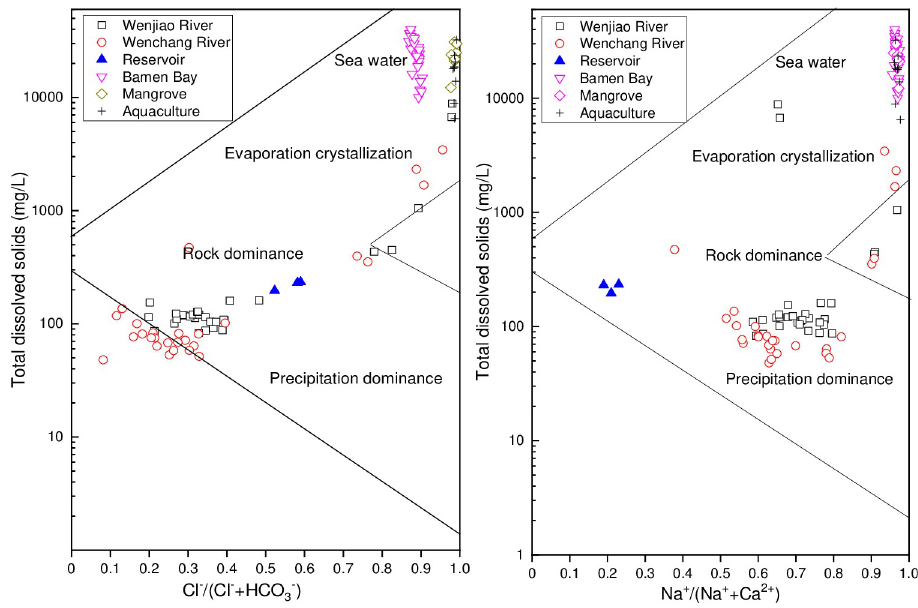
Fig 8. Gibbs plots of the TDS vs. Cl-/(Cl-+HCO3-), and TDS vs. Na+/(Na++Ca2+) of surface water monitoring stations in the Bamen Bay